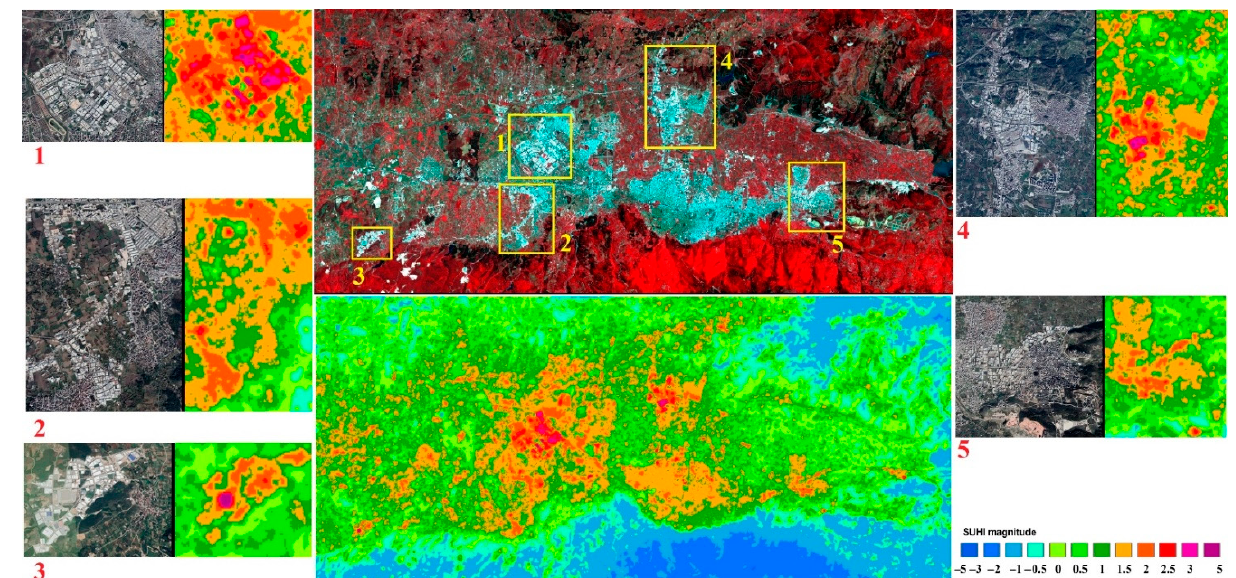
Figure 9. The Google Earth image and SUHI map of the areas shown in the false color Landsat image (2020) and SUHI map of the study area: 1. Bursa organized industrial site; 2. Nilufer small industrial site; 3. Hasanaga organized industrial site; 4. Demirtas organized industrial site; 5. Kestel organized industrial site.